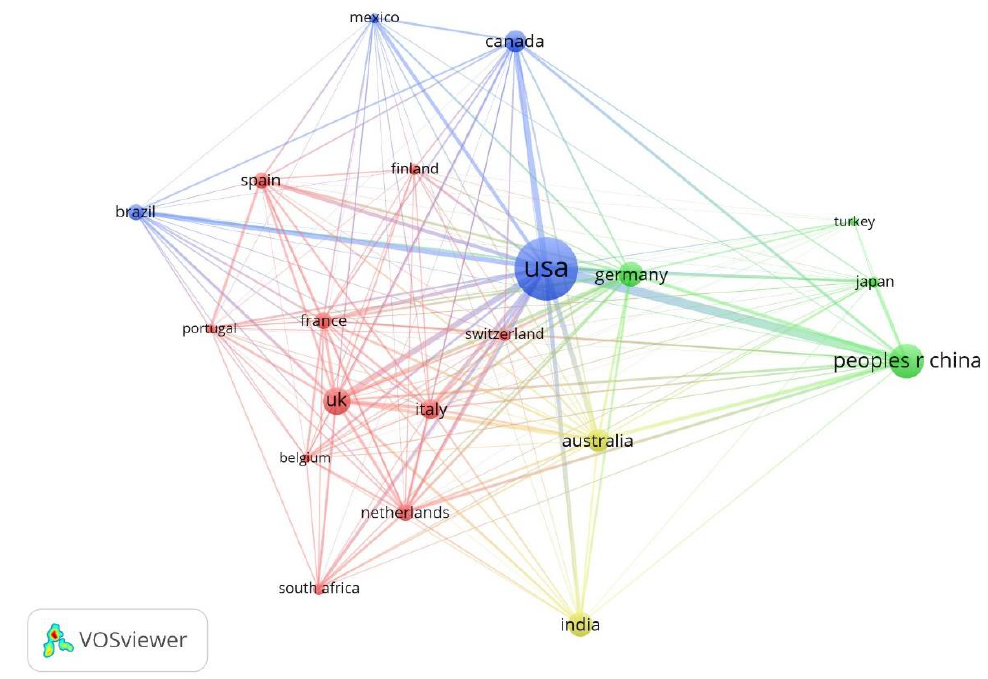
Figure 4. Co-authorship cooperation between productive countries. Each node represents a country. The size of the nodes reveals the citations of the countries, while the thickness of the lines between them shows the strength of collaboration. Table 2. 5 main clusters for country collaboration.